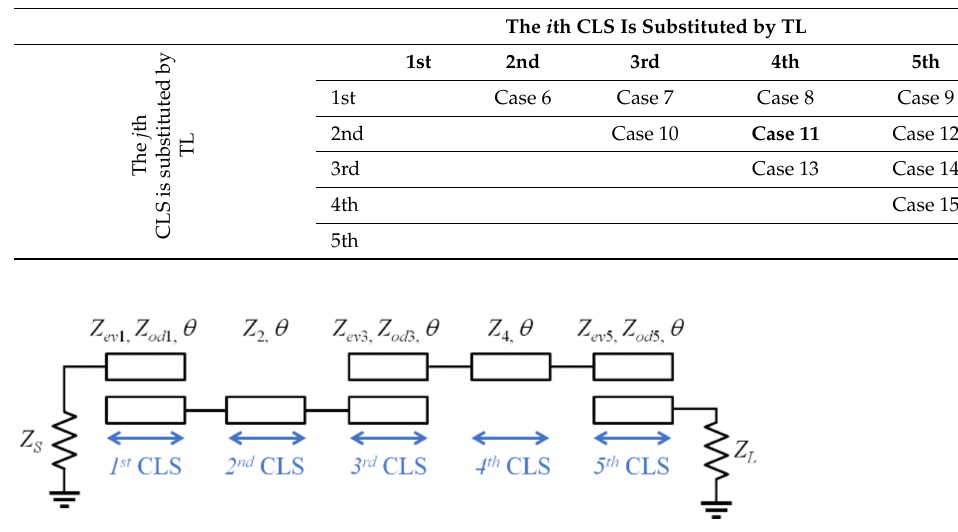
Figure 6. For fabrication convenience, the odd-mode characteristic impedance of the third CLS is fixed to 0.6 Ω ( Z od 3 = 0.6 Ω ). Since the second and fourth CLSs are substituted by TLs, Z ev 2 = 2 Z 2 , Z od 2 = 0 and Z ev 4 = 2 Z 4 , Z od 4 = 0 can be derived. Table 3. The substitutable cases in category II.